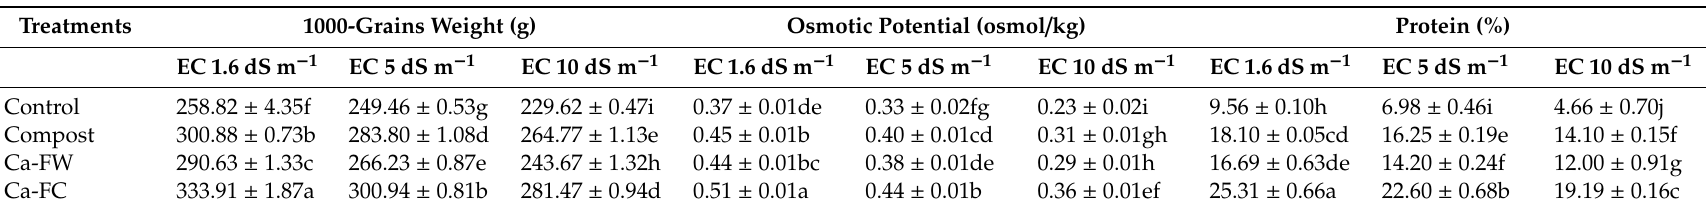
Table 2. E ff ect of compost, Ca-FW, and Ca-FC on 1000-grains weight, osmotic potential, and protein contents of maize ( Zea mays L.) under saline–sodic soil conditions.